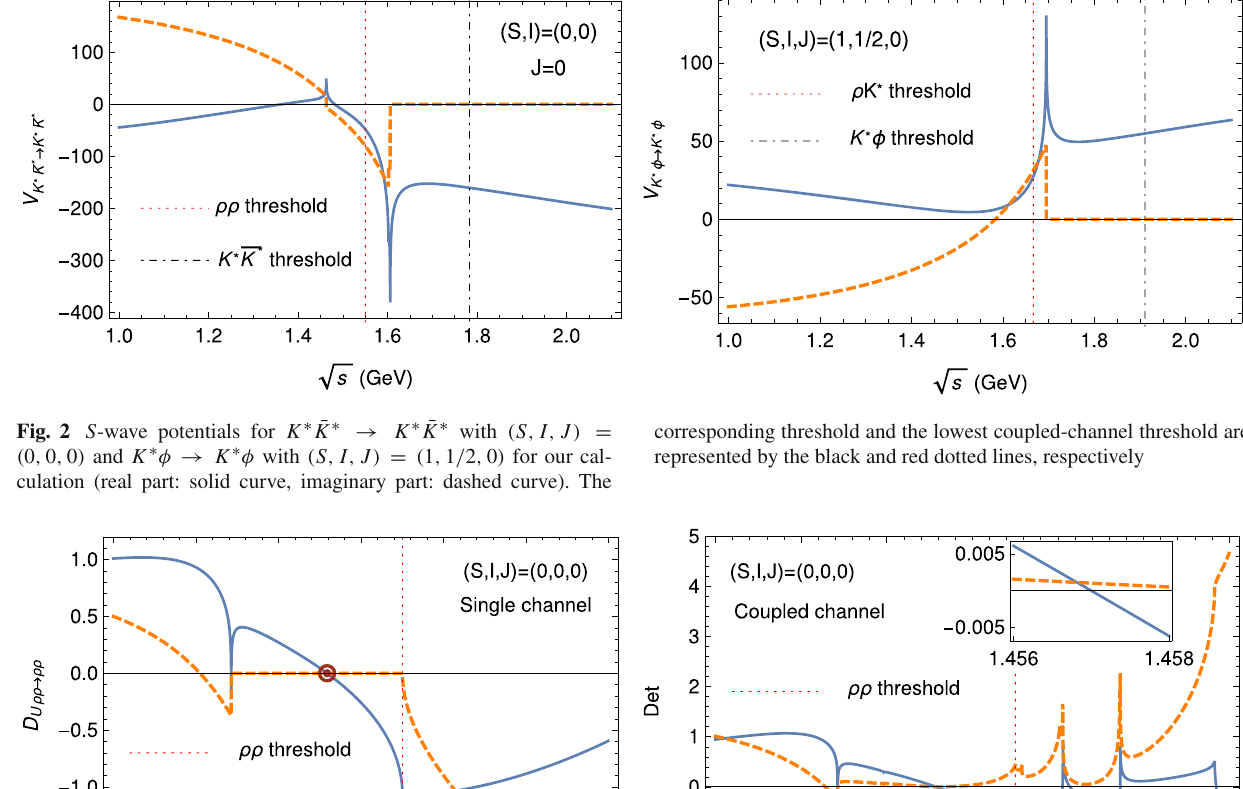
curve). Note that the imaginary part and real part of the determinant for the coupled-channel case do not vanish at the same point along the real axis below the threshold, and thus no bound state is